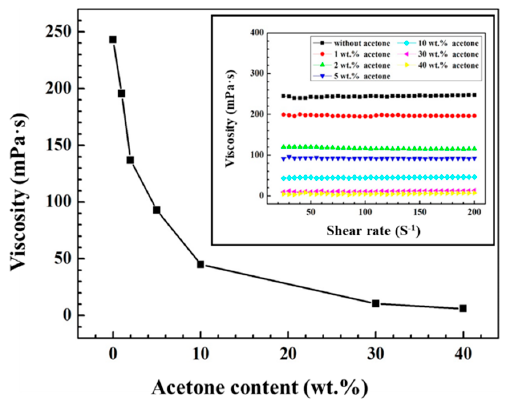
Figure 4. The variation in viscosity with different acetone content of liquid polycarbosilane (L-PCS) solutions.